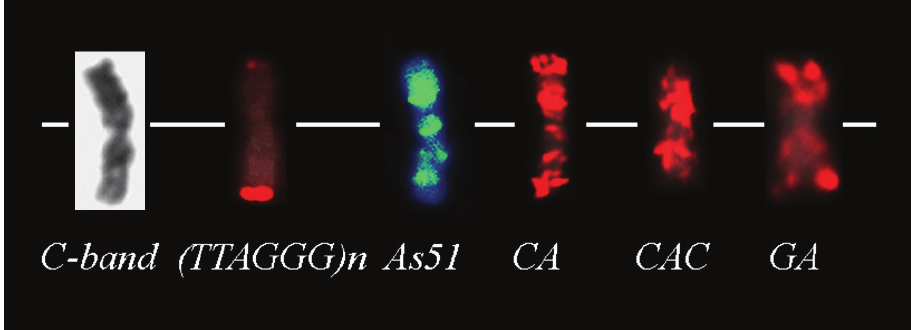
Figure 3. B chromosome of Astyanax scabripinnis showing the chromatin and localization of DNA sequences by